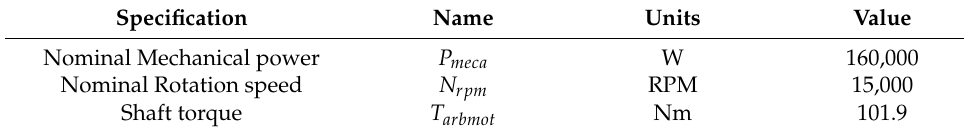
Table 2. Design specifications of the machine to be analyzed.